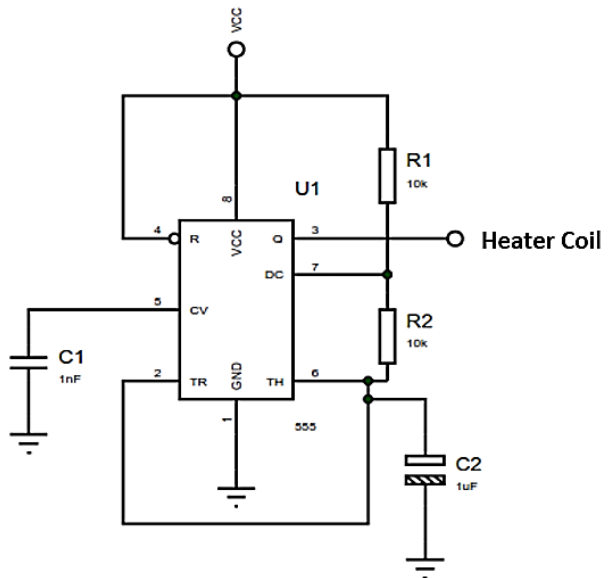
Figure 5. Generator Circuit, Pulse Width Modulation (PWM).